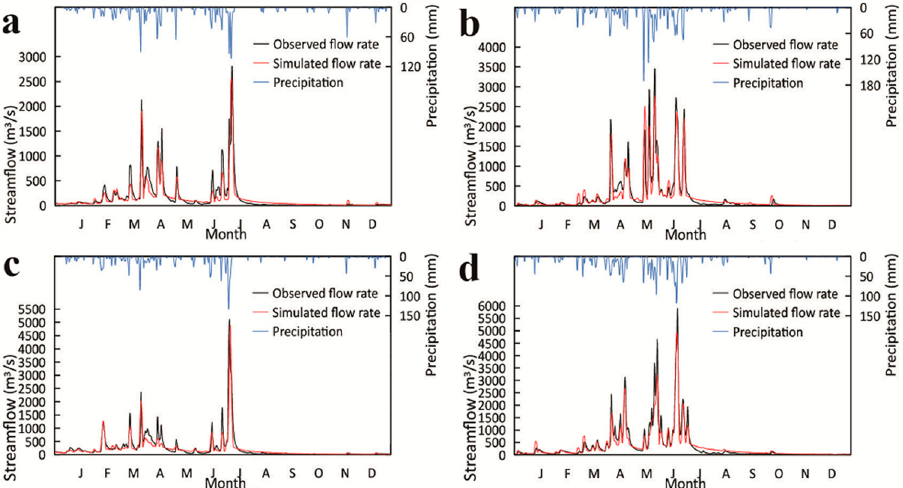
Figure 6. Observed and simulated streamflow in the calibration and validation periods. ( a )Dufengkeng Station, 1966. ( b ) Dufengkeng Station, 1995. ( c ) Hushan Station, 1966. ( d ) Hushan Station, 1995.